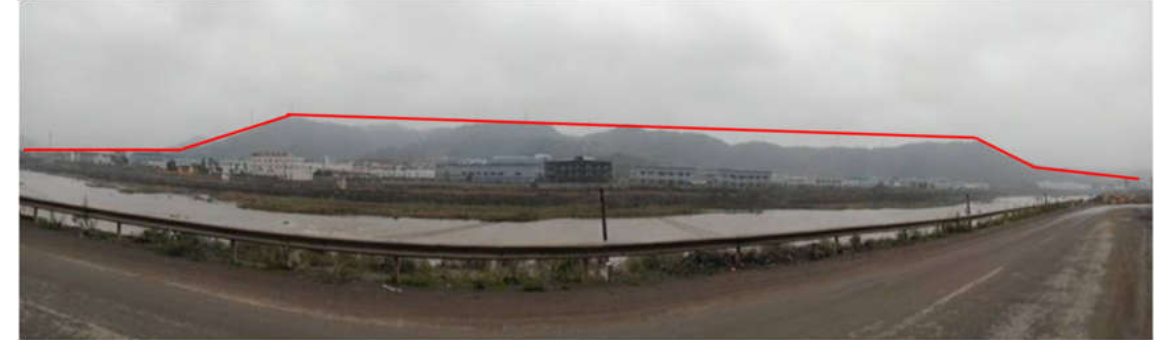
Figure 1. Basalt platform.